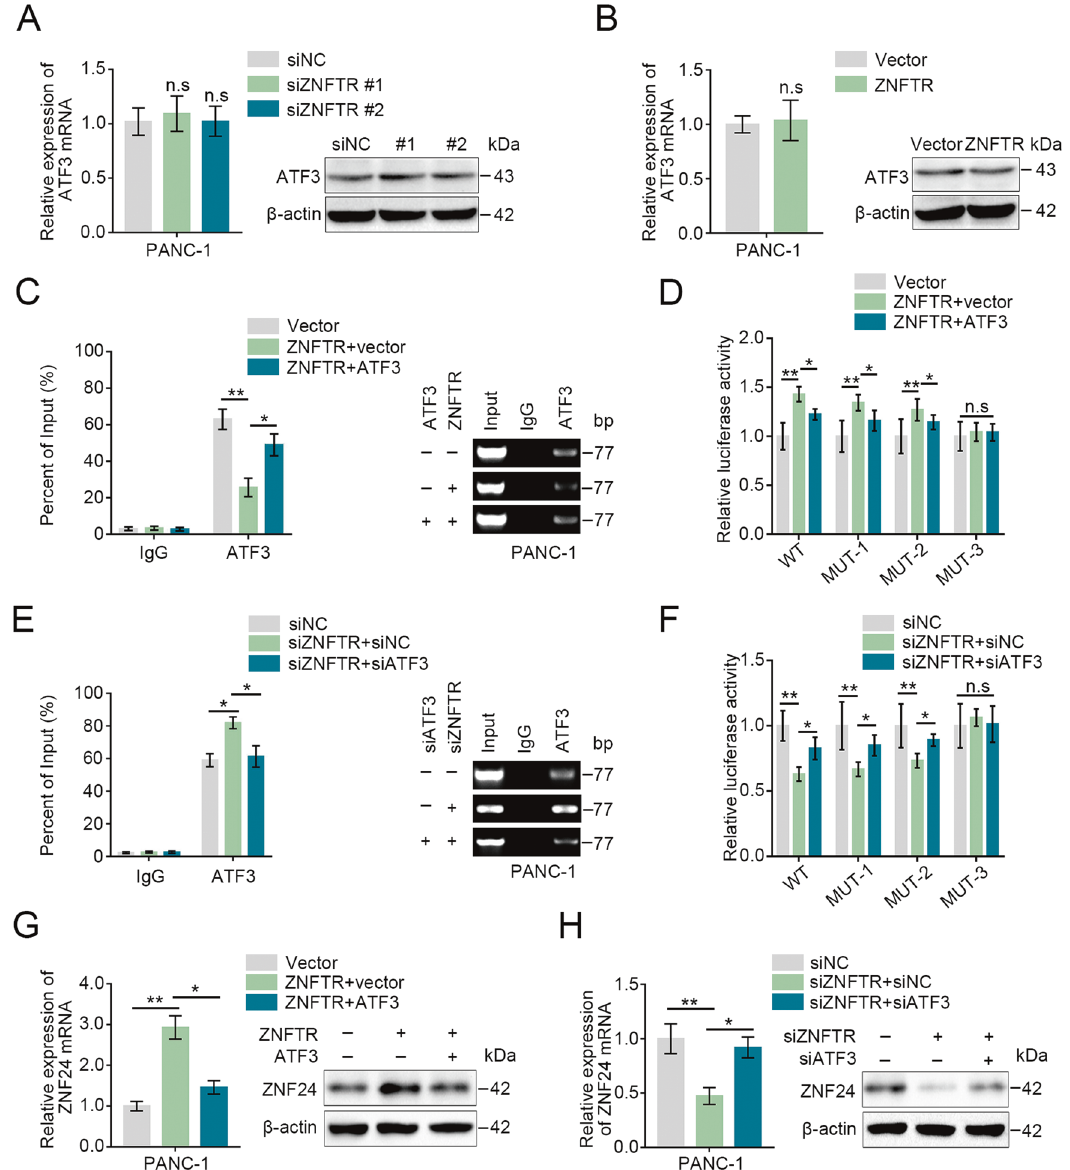
has no signi fi cant relationship with ZNFTR, and ZNF24 was positively related to ZNFTR and negatively related to VEGFA (Fig. 7A). Furthermore, Pearson ’ s correlation analysis and chi - square test showed a positive correlation between the expression of ZNFTR and ZNF24 in PC patients (Fig. 7B). The expression of ZNFTR and VEGFA indicated a negative correlation by the chi - square test (Fig. 7B). Consistently, we got the same tendency via the immunohistochemistry (IHC) assay in PC patients ’